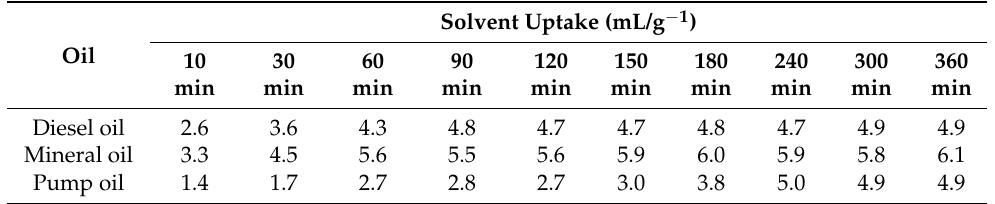
Table 2. Oil adsorption by X-Ca-alginate aerogel beads at various time intervals.